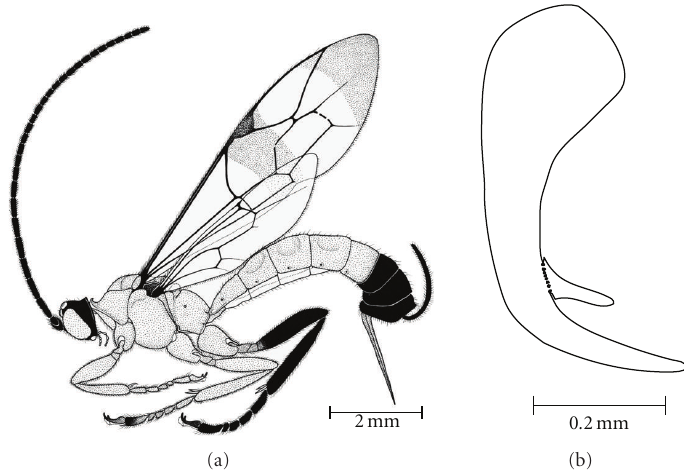
Figure 3: T. matamatae sp.n.: holotype female habitus (a) and fore tarsal claw